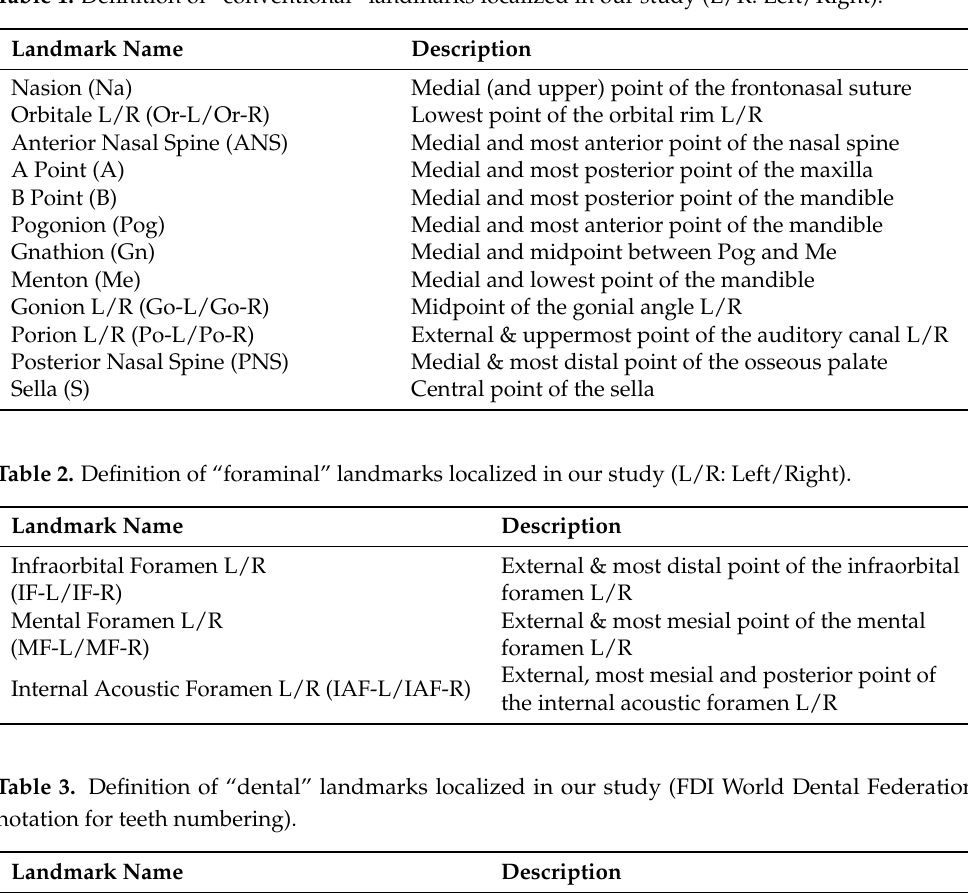
Figure 1. Illustration of the set of 33 landmarks localized by the operators, and the new coordinate system used for statistical analysis. In the case of bilateral landmarks, only one of the two landmarks is labelled. Dotted lines show landmarks localized inside bony structures. Table 1. Definition of “conventional” landmarks localized in our study (L/R: Left/Right).